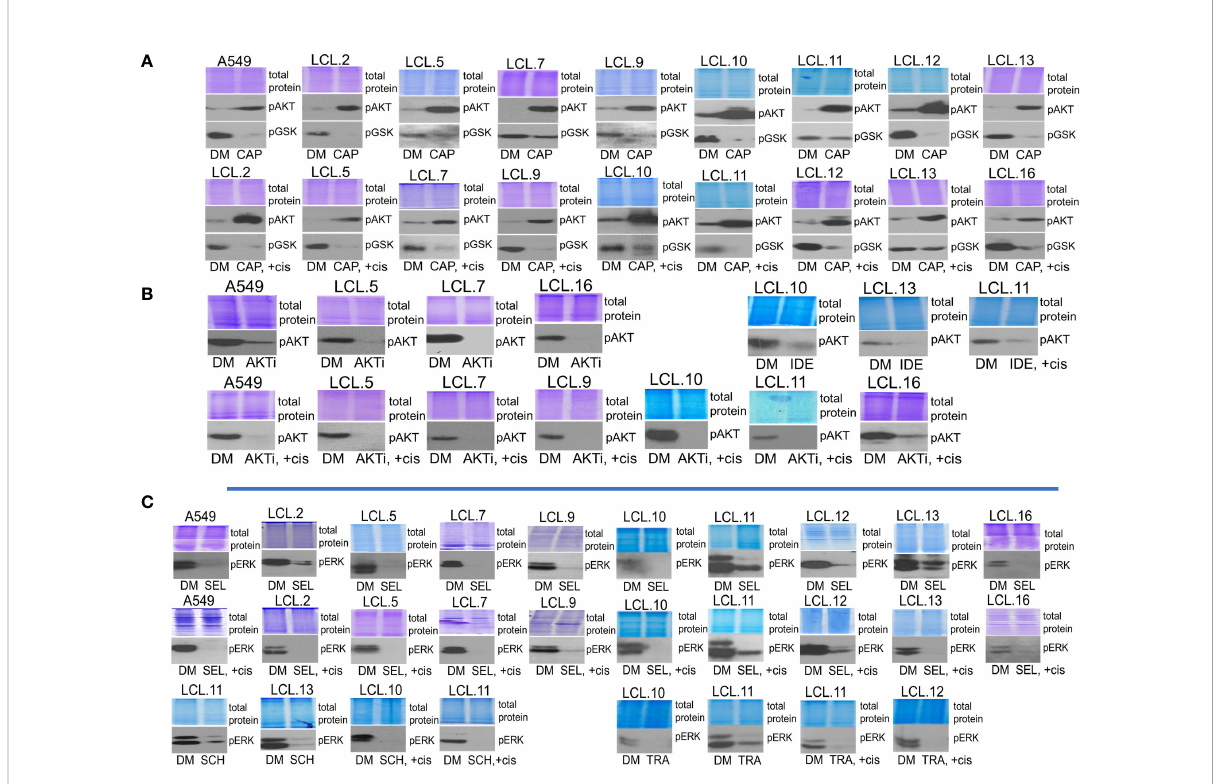
FIGURE 5 Determining the ef fi cacy of targeted drugs by phosphorylation of their targets. (A) Capivasertib, an AKT inhibitor, increases the phosphorylation of AKT itself. Capivasertib ef fi cacy is demonstrated by inhibited phosphorylation of GSK3 b , a downstream target of AKT. DM – vehicle control (DMSO), CAP – capivasertib, +cis – cisplatin. (B) AKT inhibitor VIII (AKTi) and PI3K inhibitor idelalisib (IDE) reduce AKT phosphorylation in control and cisplatin-treated cells. (C) MEK/ERK signaling inhibitors suppress ERK1/2 phosphorylation in control and cisplatin-treated cells. SEL – selumetinib, SCH – ERK inhibitor SCH772984, TRA – trametinib. Representative Western blots are shown. Coomassie-stained protein gels are presented as loading controls. 6-hour-long exposures to the drugs were used. The concentration of cisplatin was 90 µM, and that of inhibitors was 10 µM except for trametinib and SCH772984 (1